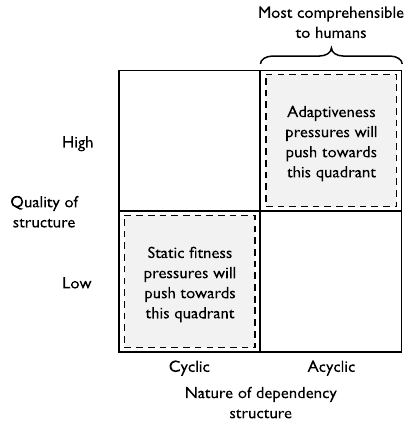
Figure 3. The evolution of information structure.